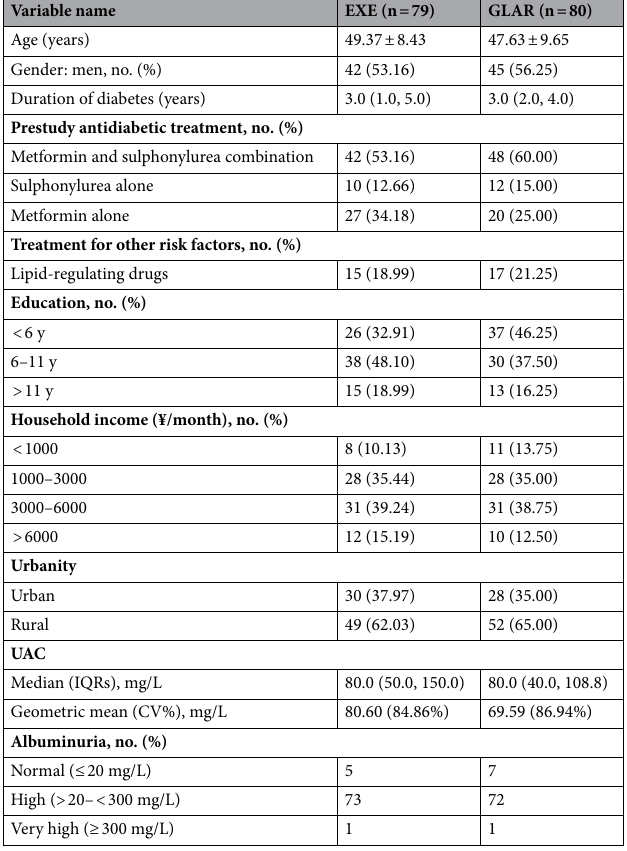
Table 1. Baseline characteristics of the two groups. Data are presented as frequencies with percentages, median (IQRs), and mean ± SD. UAC, urine albumin